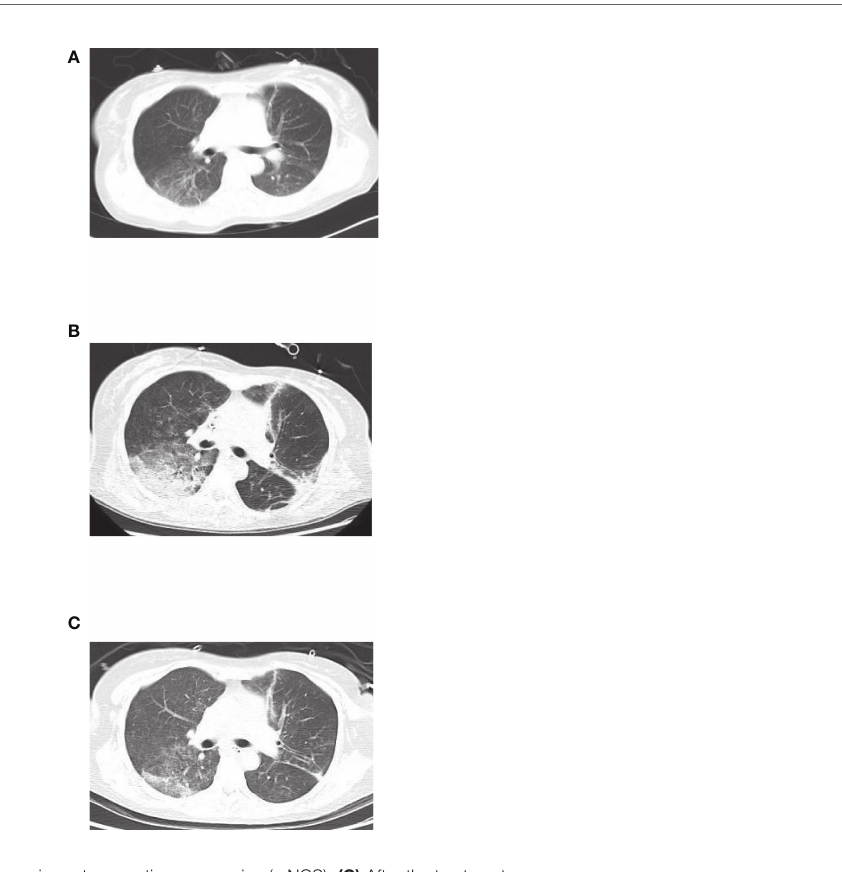
FIGURE 1 | (A) Before treatment. (B) Before metagenomic next-generation sequencing (mNGS). (C) After the